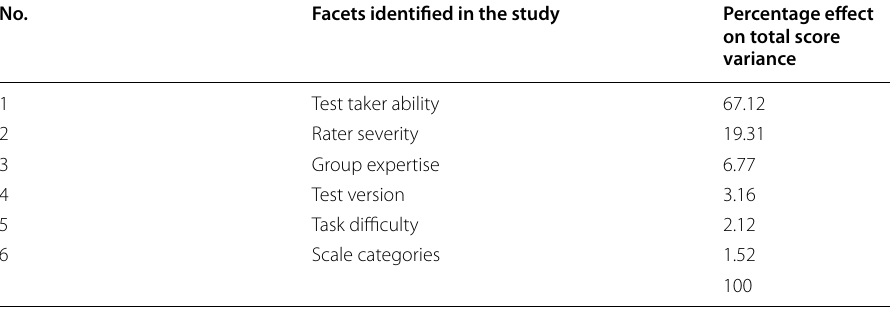
Table 6 Effect of each facet on total score variance (immediate post‑training)